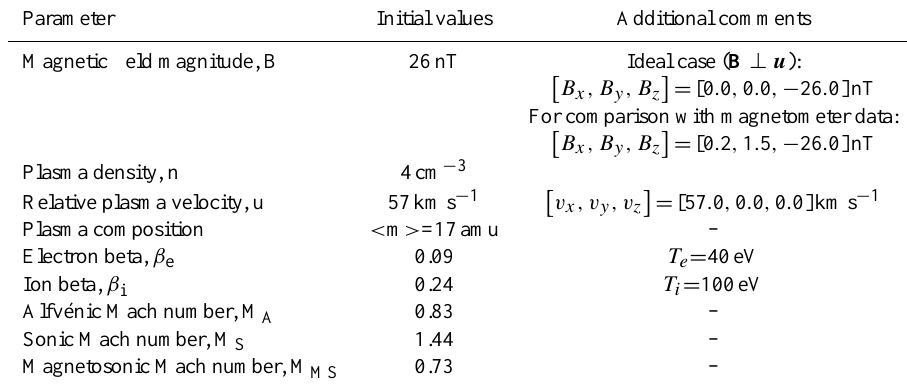
Table 2. List of parameters used for the two simulation runs. Parameter Initial values